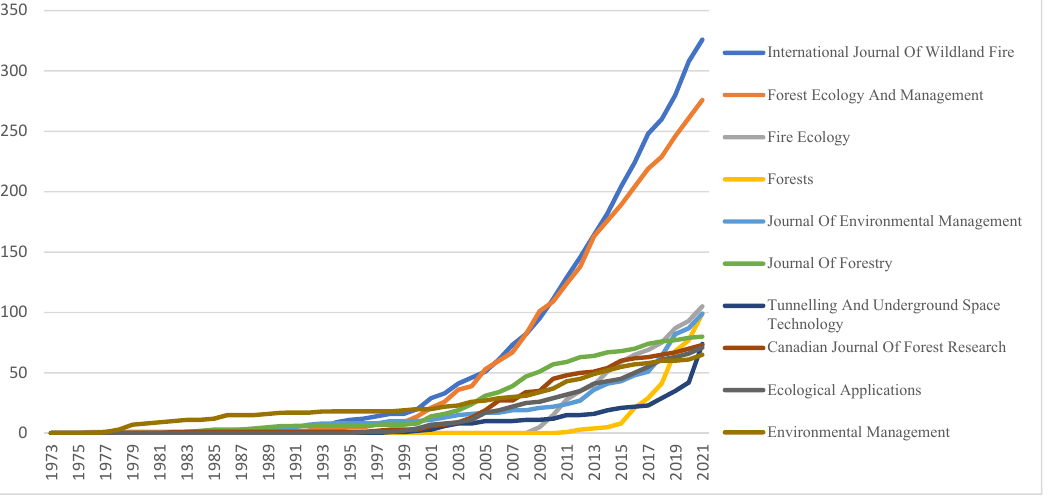
Figure 2. Yearly number of publications of the 10 main sources on fire management indexed in Scopus (1973–2021). Table 2. Most-influential publications on fire management by number of citations registered in Sco- pus (1973–2021).